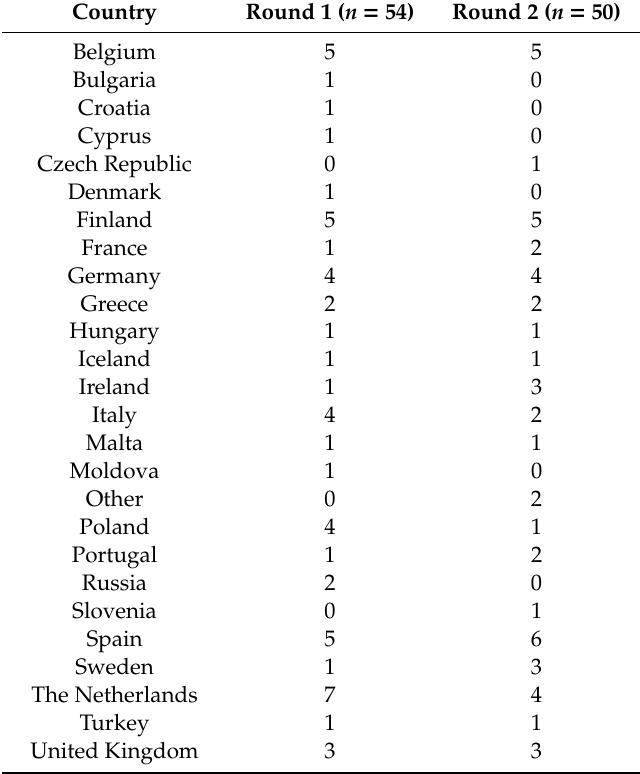
Table 2. Location of